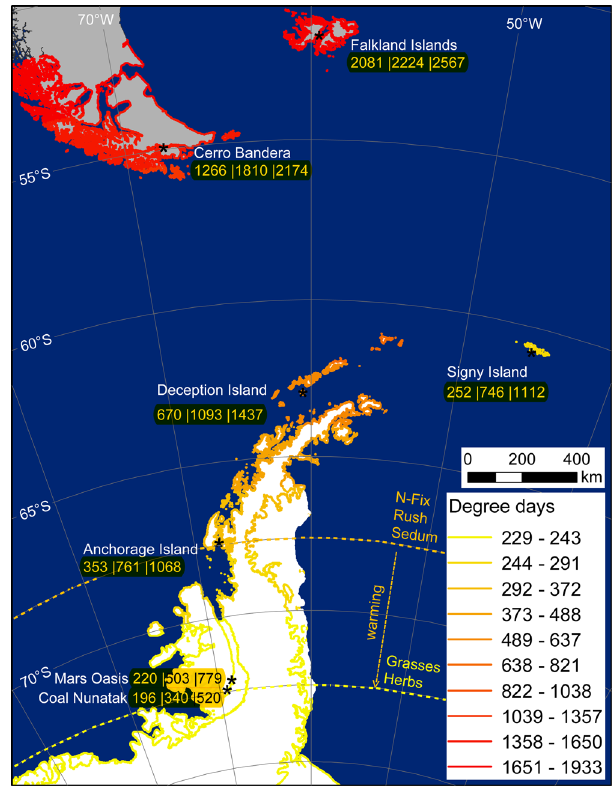
Fig. 4 Current soil surface degree day sums for coastal ice-free regions along the Antarctic Peninsula. Location names indicate where soil surface temperature was recorded (see Supplementary Table 5 and Fig. 3). Values represent: measured degree day sums and recalculated values following warming scenarios of + 3 or + 5 °C (current| + 3 °C| + 5 °C). The curved dashed line indicates the potential southern germination limit for the tested non-native plant types, based on the experimental study, with the arrow indicating the likely shift in germination limit as temperatures rise. No extrapolations on soil degree day sums were made beyond Coal Nunatak due to lack of temperature records further south. Therefore, species limits are bound by the same restrictions. Signy Island has a much lower degree day sum than would be expected from its latitude due to high cloud cover and this may also be the case at other extrapolated locations. Note that much of the Antarctic Peninsula coastline is currently not free from ice and the degree day sums re fl ect potential values if no ice was